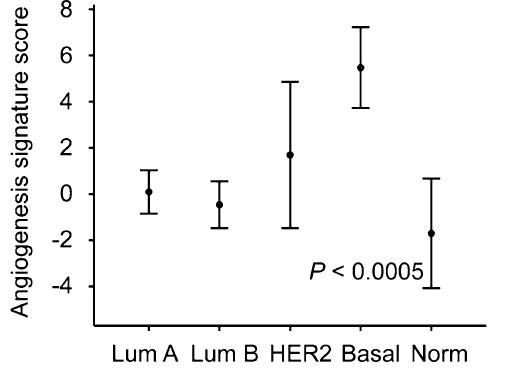
Figure 4. MVD, pMVD and the 32-gene angiogenesis signature score across intrinsic molecular breast cancer subtypes. MVD: microvessel density; pMVD: proliferative microvessel density, Lum: luminal; HER2: HER2-enriched, Basal: basal-like; Norm: normal breast-like. P -values by the Kruskal–Wallis test, and error bars with 95% confidence interval of the mean. Number of patients; MVD and pMVD: N = 127 (Basal: N = 20, HER2: N = 9, Lum A: N = 53, Lum B: N = 40, Norm: N = 5), angiogenesis signature score: N = 131 (Basal: N = 21, HER2: N = 9, Lum A: N = 55, Lum B: N = 40, Norm: N =